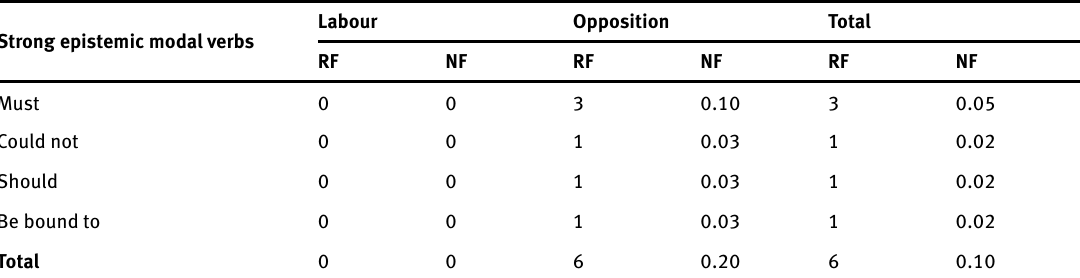
Table 3: Strong epistemic modal